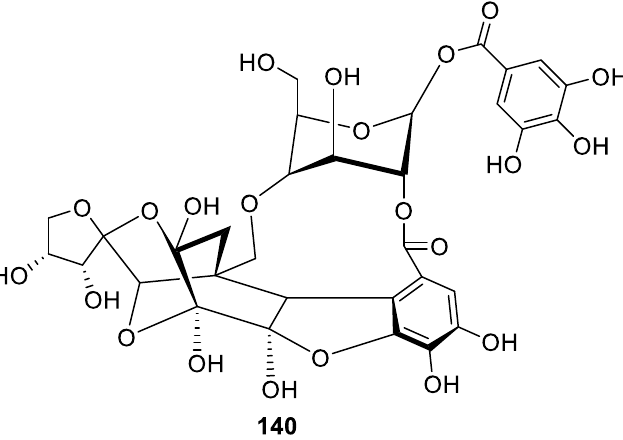
Phyllanthus emblica . Figure 66. Natural product phyllanthunin possessing a [4.7.0] spirocyclic moiety isolated from